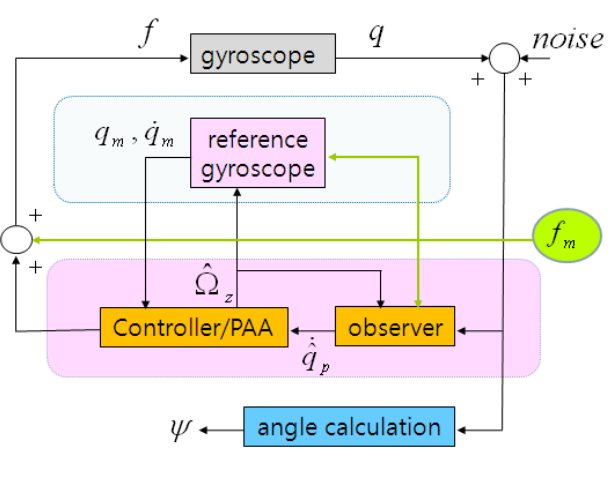
Figure 2. Proposed adaptive control scheme.